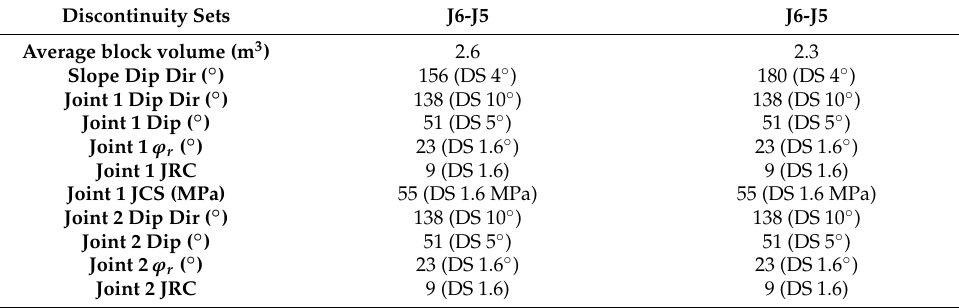
Table 12. Probabilistic stability analysis results for wedge